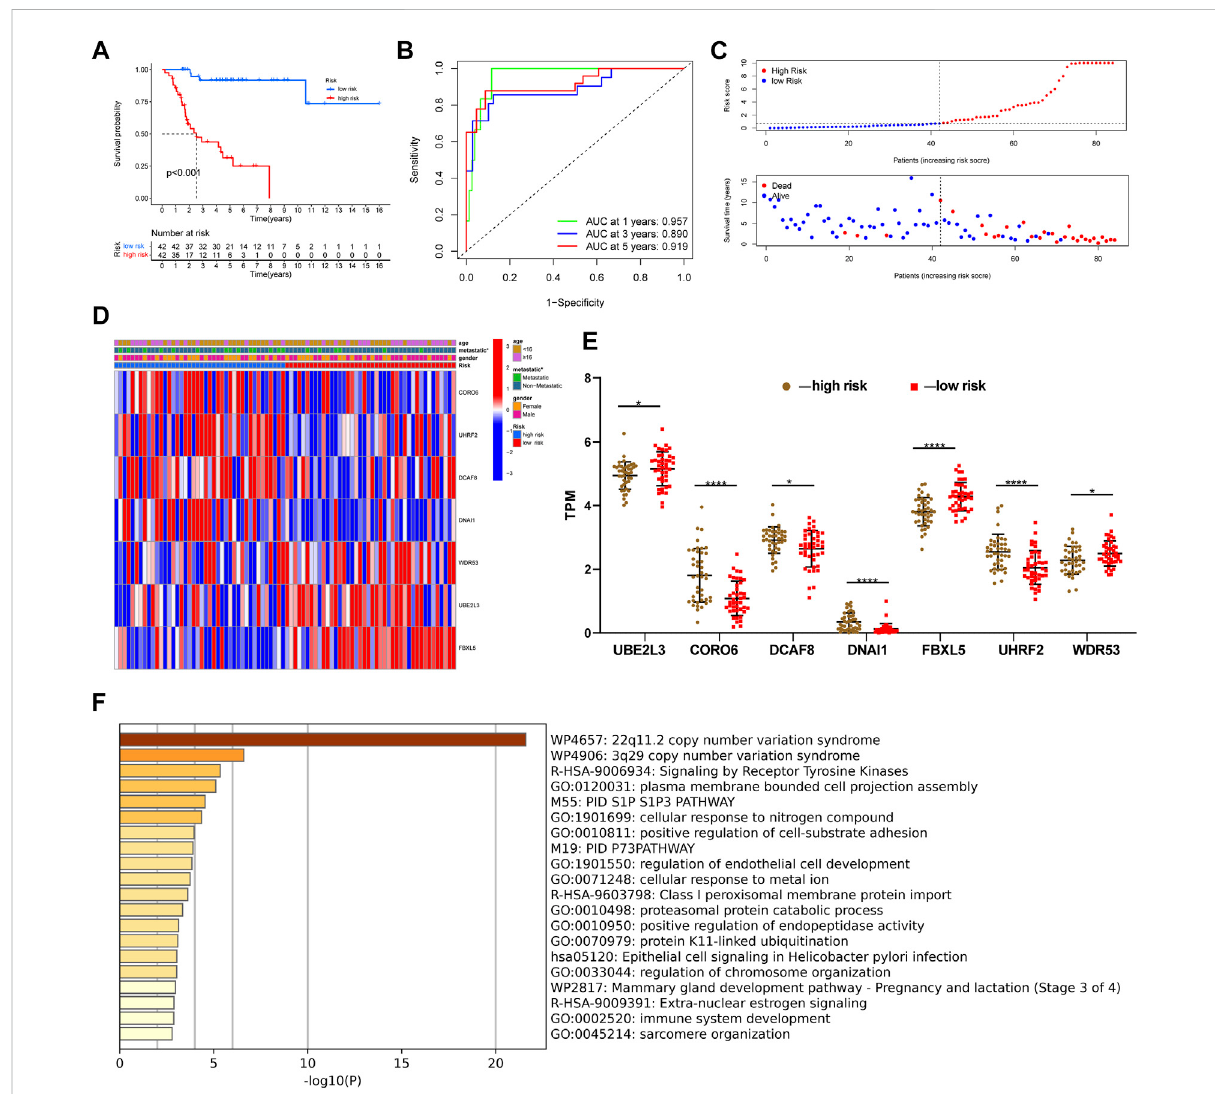
FIGURE 3 Evaluatingaubiquitin-relatedgenesignature. (A) TheKaplan – MeiersurvivalcurveintheTargetset. (B) TheROCcurvesintheTargetset. (C) Risk score distribution and survival status of OS patients in the Target set. (D) Heatmap of seven ubiquitin-related genes with combining clinical information in the Target set. (E) Differential expression of these seven genes between high and low-risk groups. (F) Functional annotation of co- expression genes through the metascape. * p < 0.05, ** p < 0.01 , *** p < 0.001, **** p <